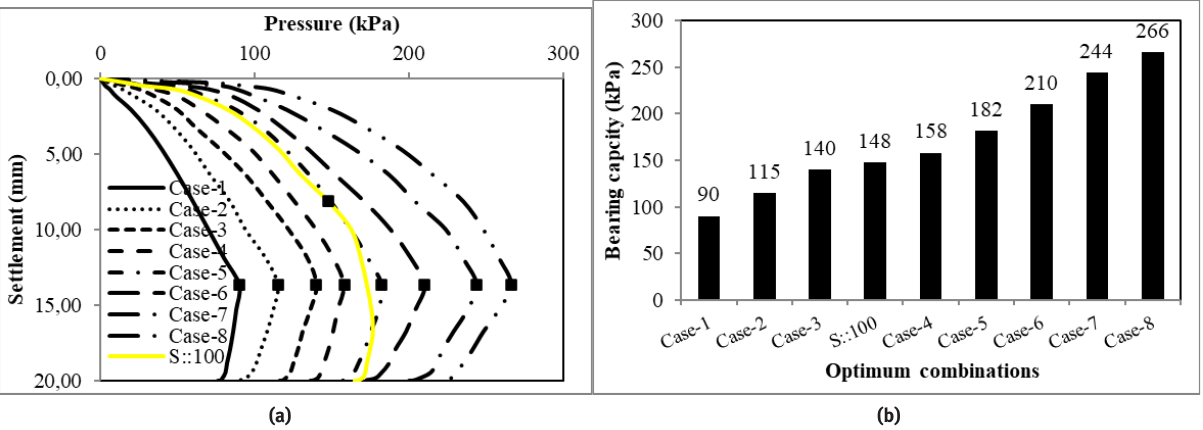
Figure 11: (a) Pressure–settlement curves and (b) bearing capacity values of two-layered soil for all cases at h/B=2.275 and single-layer sandy soil for L/B=1.